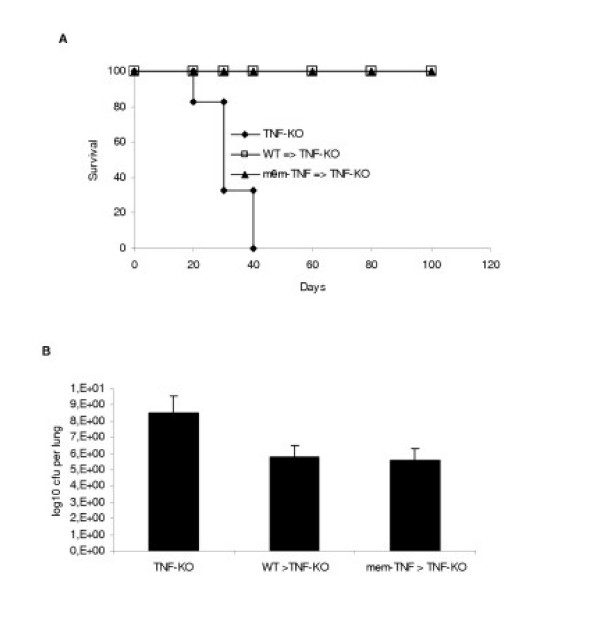
Bone marrow cells from mem-TNF mice correct the heightened susceptibility of TNF deficient mice. Long-term survival of TNF-KO mice reconstituted with bone marrow from mem-TNF or WT mice (A), and control of infection in the lung (B) of bone marrow reconstituted TNF-KO mice (p < 0.01). Lethally irradiated (8 Grey) and reconstituted TNF-KO were exposed to infection (Mtb 100 CFU, intranasal administration) 4 months after irradiation and bone marrow reconstitution. The results are expressed as mean values ± SD (n = 6).